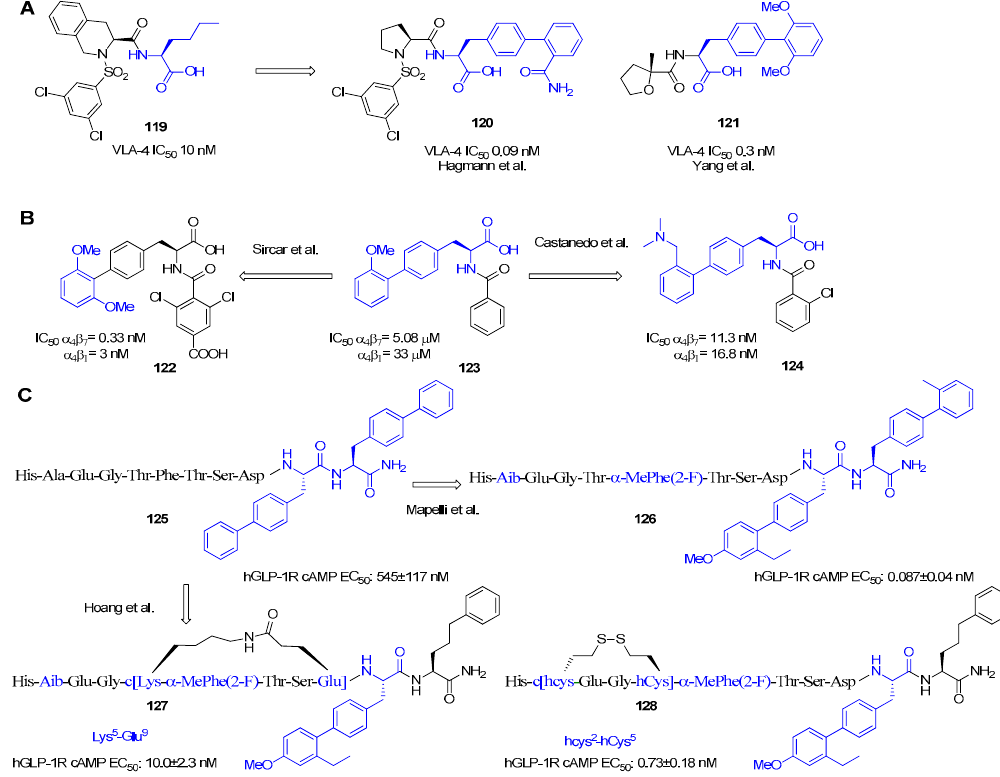
Figure 17. ( A ) Synthesis of dipeptide ligands 120 and 121 with inhibitory activity for integrin VLA-4. ( B ) Dual α 4 β 1 / α 4 β 7 integrin antagonists 122 and 124 . ( C ) Short GLP-1 analogues 126 – 128 that are improved by amino acid substitution ( 126 ) and introduction of secondary motifs by backbone cyclization ( 127 and 128 ).